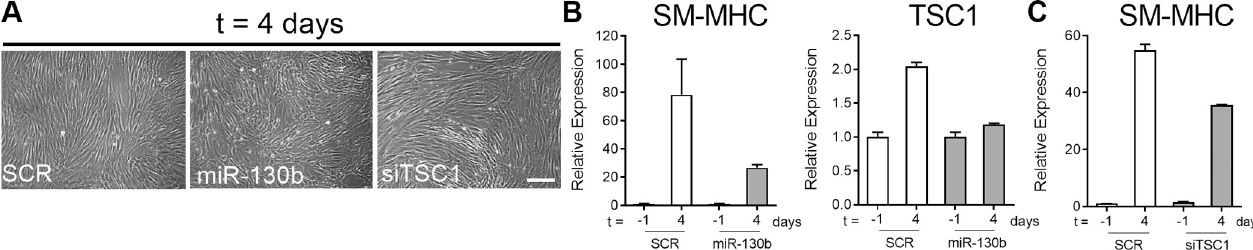
Fig 6. Smooth muscle cell (SMC) differentiation is impaired by miR-130b overexpression and TSC1 repression. (A) Phase contrast images showing TXA 2 - mediated myogenic differentiation (t = 4 d) of primary hMSCs transfected with mimic control (SCR), miR-130b and siRNA targeting TSC1 (siTSC1). (B) Relative mRNA levels of the SMC marker SMMHC , and TSC1 at the 4 d endpoint following miR-130b transfection. (C) Relative mRNA levels of SMMHC at the 4 d endpoint following si TSC1 transfection. Values are normalized to control SCR levels prior to myogenic induction (t = -1 d). Data are representative of 3 independent experiments. Scale bar: 100 μ